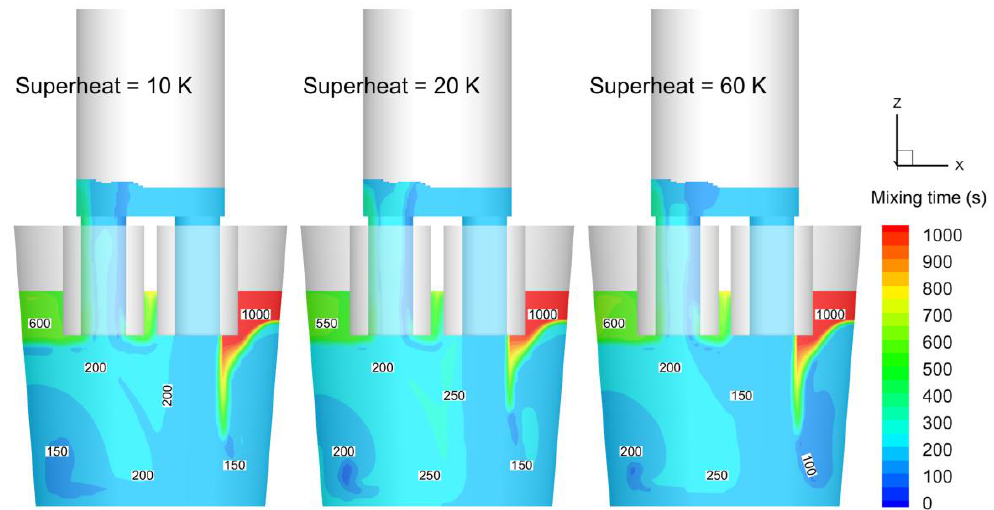
Figure 13. Effect of superheat on the distribution of alloy mixing time.